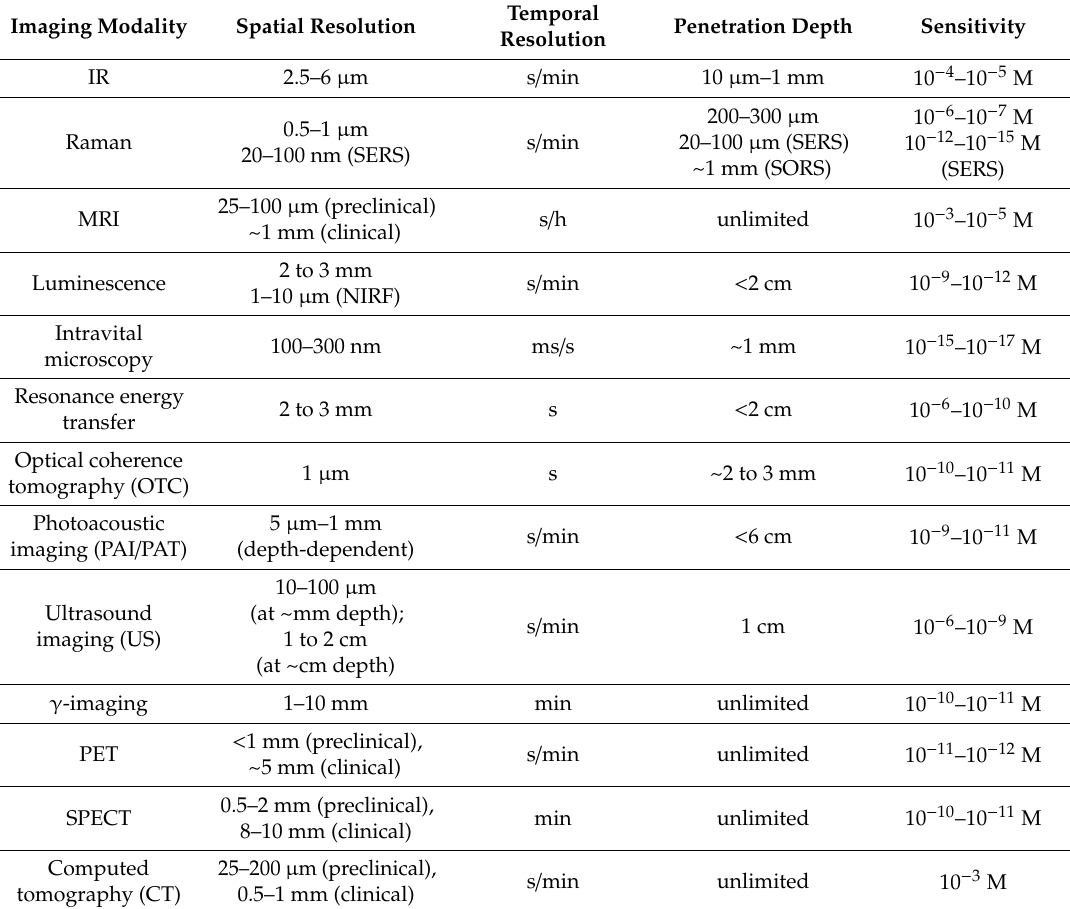
Table 2. Comparison of the features of IR / Raman imaging with those of the other main modalities used in research and clinics. These features depend on the experimental configuration [2,66]. PET: Positron Emission Tomography, SPECT: Single-Photon Emission-Computed Tomography, SERS: Surface-Enhanced Raman Scattering, SORS: Spatially O ff set Raman Spectroscopy and NIRF: Near Infrared